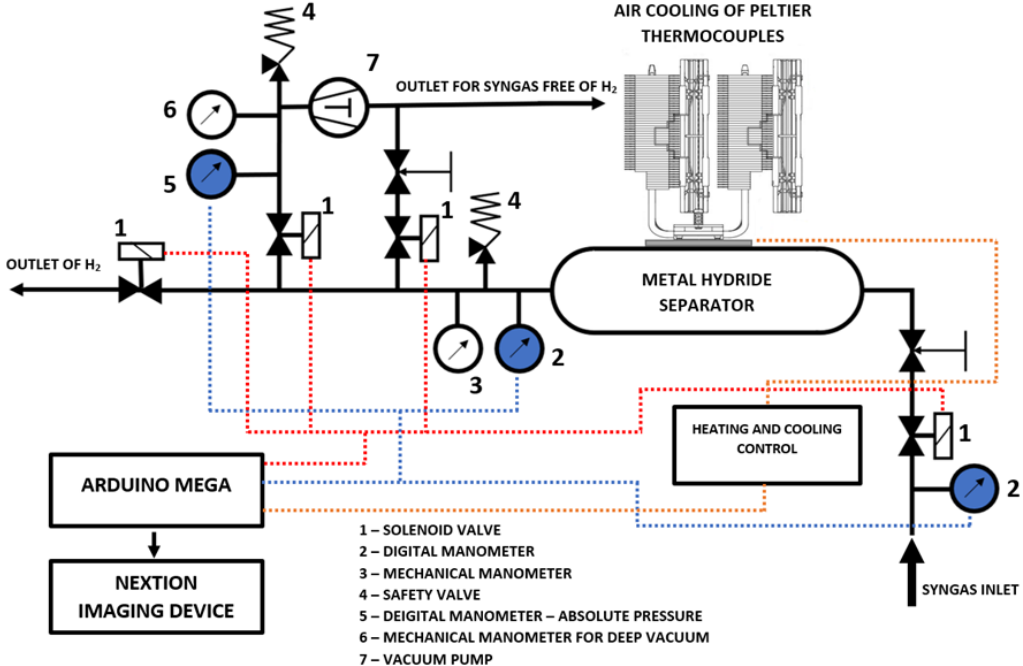
Figure 1. Functional scheme of a hydrogen separator.